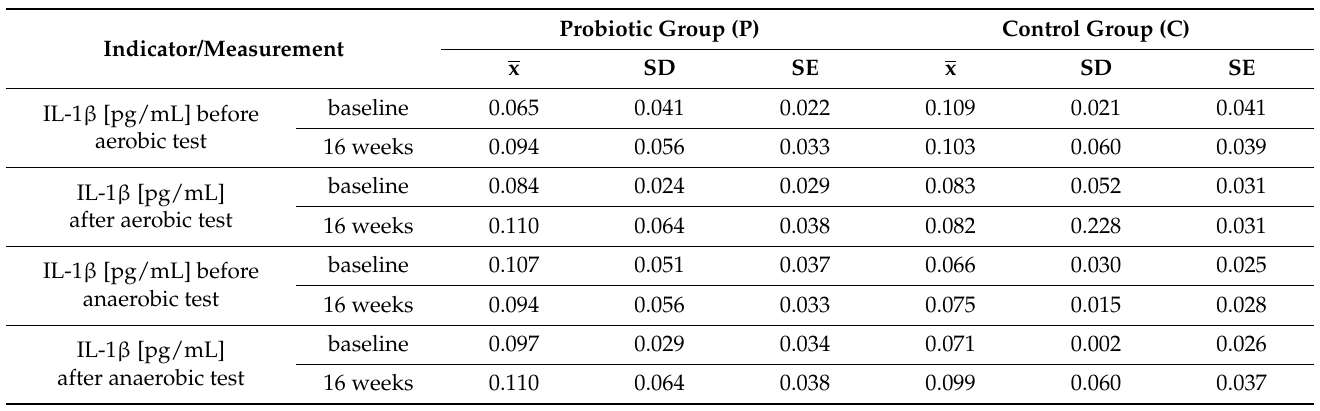
Table 9. The concentration of 1 β (IL-1 β ) pre- and post-aerobic tests and pre- and post- anaerobic test at follow-up measurements during supplementation intervention.